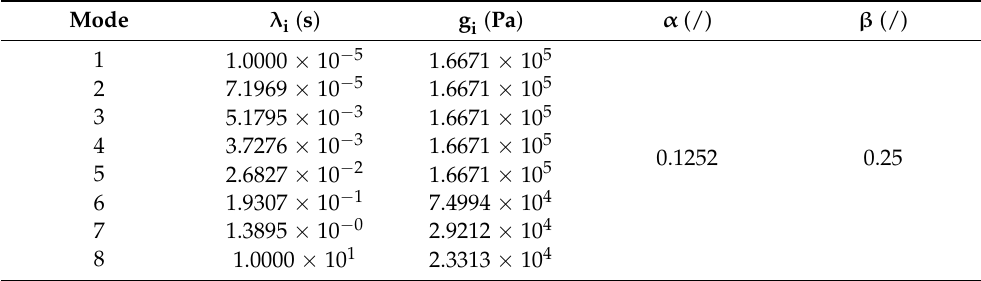
Table A1. K-BKZ/Wagner model parameters (fit 1) for gum NBR at the reference temperature of